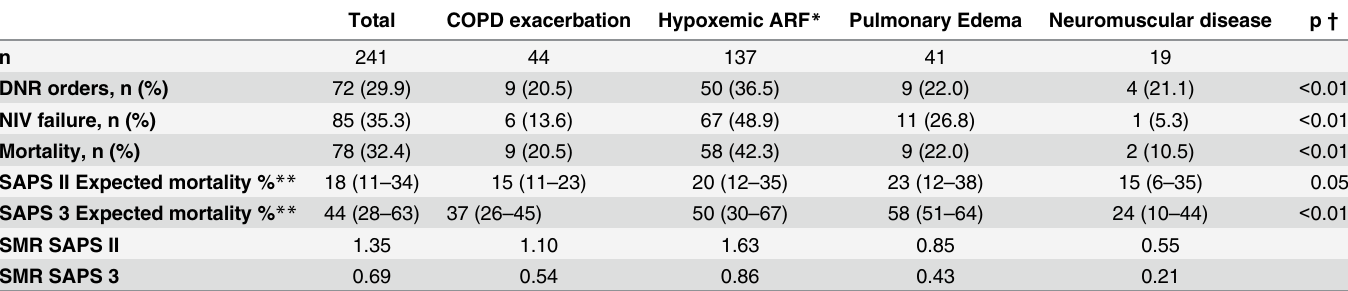
Table 2. Indications for NIV and mortality.